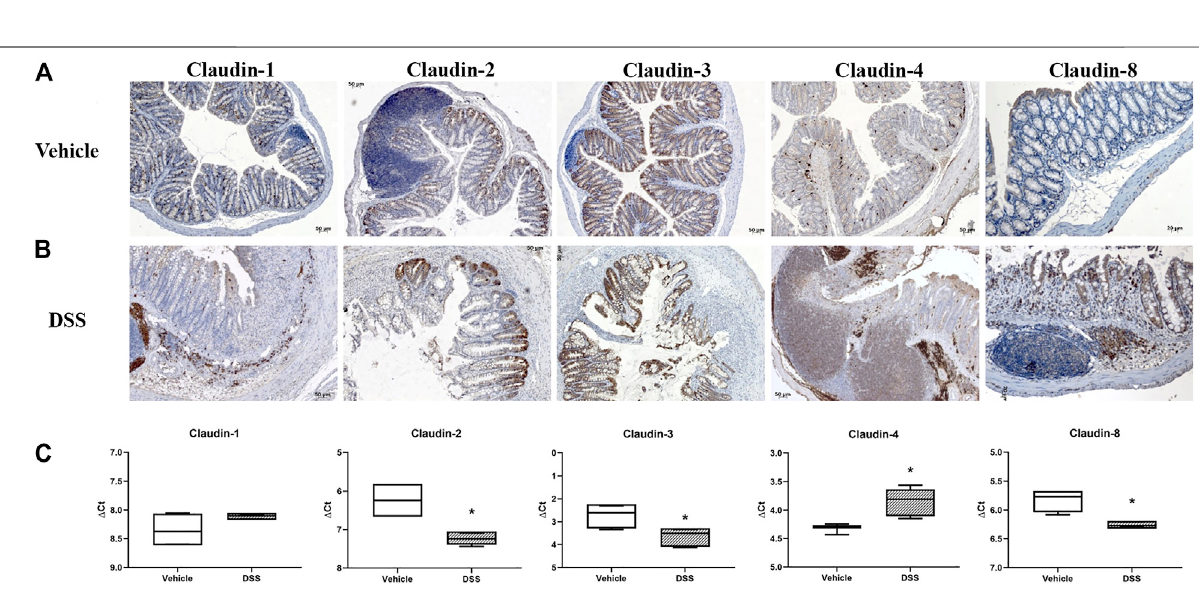
FIGURE 10 | Claudin-1, claudin-2, claudin-3, claudin-4, and claudin-8 expression in DSS-induced colitis, a murine model of IBD. (A) Overview of claudin-1, claudin-2, claudin-3, claudin-4, and claudin-8 expression pattern (IHC) in naive C57Bl6N mice; (B) overview of claudin-1, claudin-2, claudin-3, claudin-4, and claudin-8 expressionpattern(IHC)inDSS-treatedmice; (C) claudinmRNAexpressedas Δ CTvaluefromclaudinCTnormalizedtotheGAPDHCT.Dataarepresentedasbox-and- whiskerplots, withmedian and whiskersextendingfrom 5to95percentiles(one representative experiment: four naiveanimalsand fi veanimals exposed toDSS). t Test, p < 0.05 vs. naive